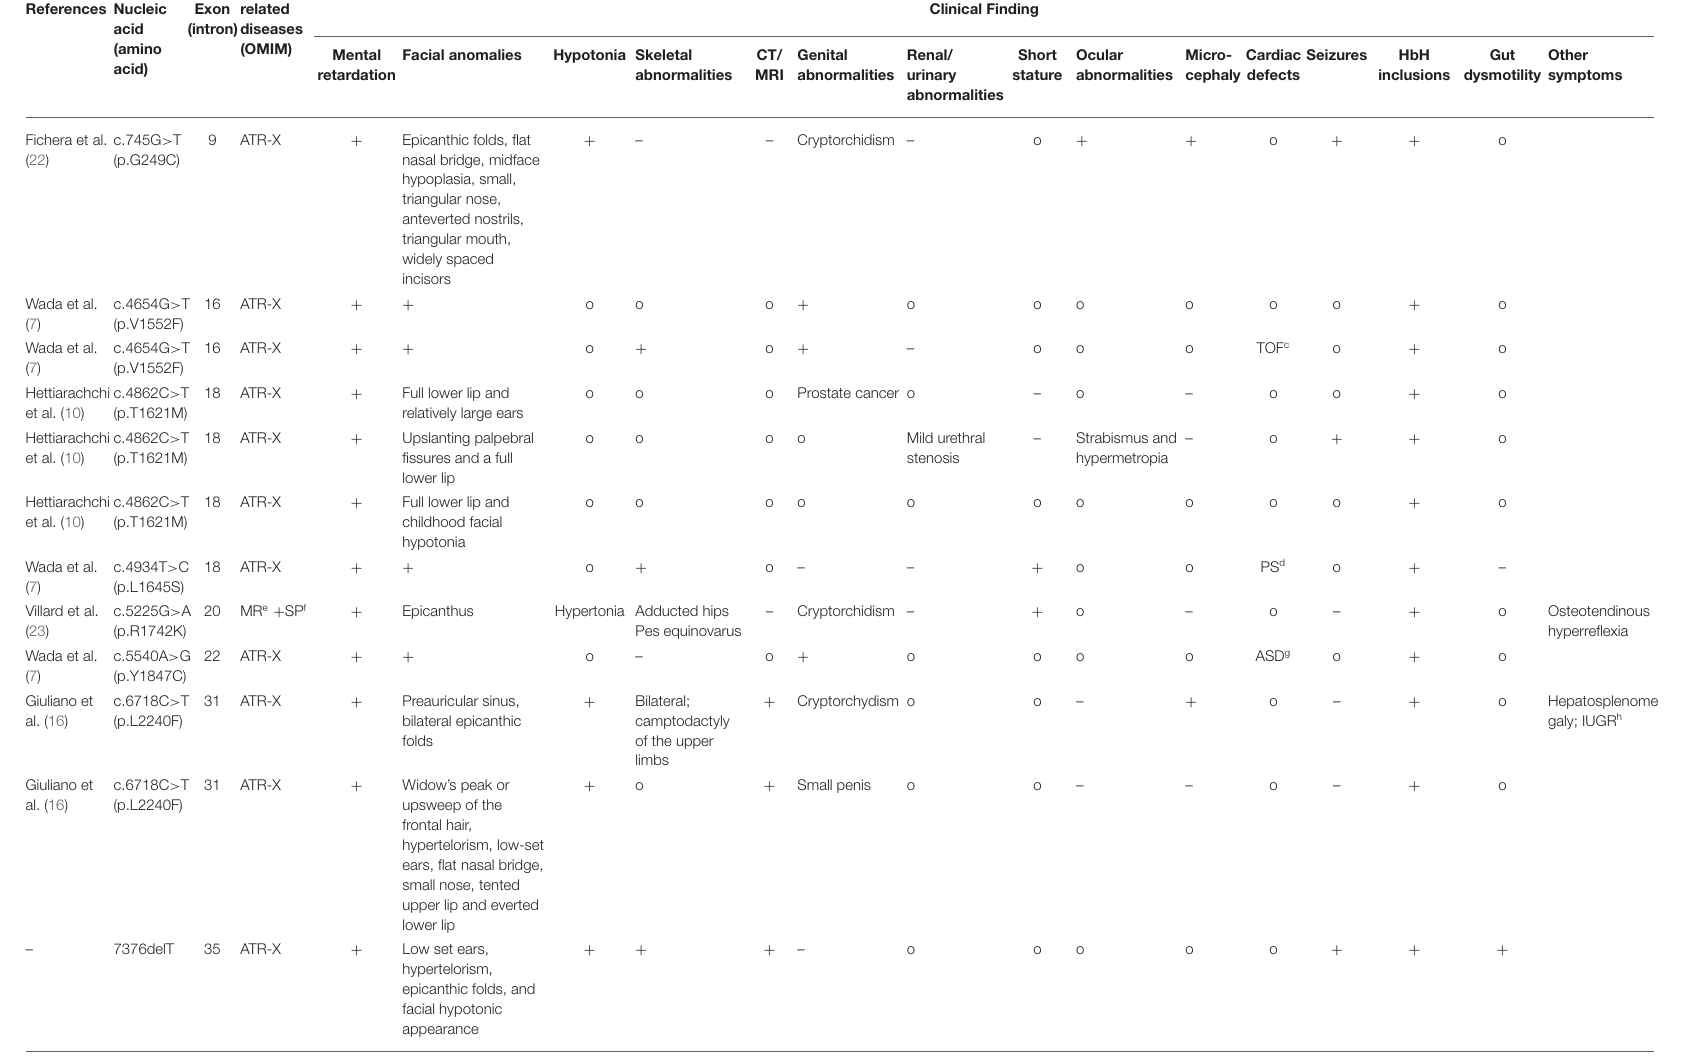
+ , present; –, absent, o, data not available. a ATR-X, ATRX syndrome; b Arrhythmia; c TOF, tetralogy of fallot; d ps, pulmonary stenosis; e MR, mental retardation; f SP, spastic paraplegia; g ASD, atrial septal defect; h IUGR, intra uterine growth retardation. CT/MR serial number (2) mild dilatation of the lateral ventricles and subarachnoidal spaces; (7) Cortical atrophy; (21) brain MR was normal (when he was 5 months) non-specific progressive white matter abnormality and cortical atrophy (when he was 18